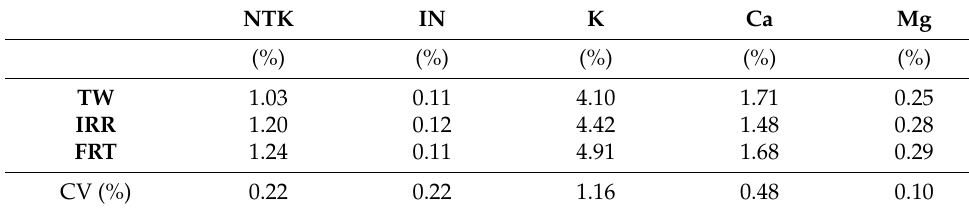
Table 3. Macronutrient concentrations of leave-in dry